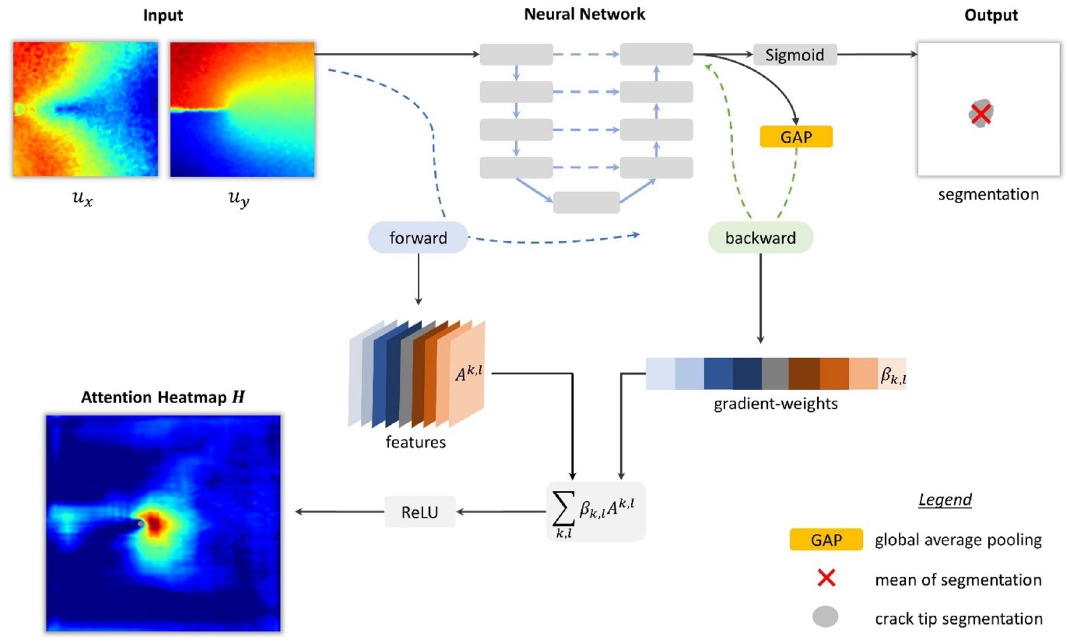
Figure 2. Grad-CAM method for visualization of deep neural network’s attention. Internal features of the neural network collected during a forward pass of input data are combined by weighting with average pooled gradients computed during a backward